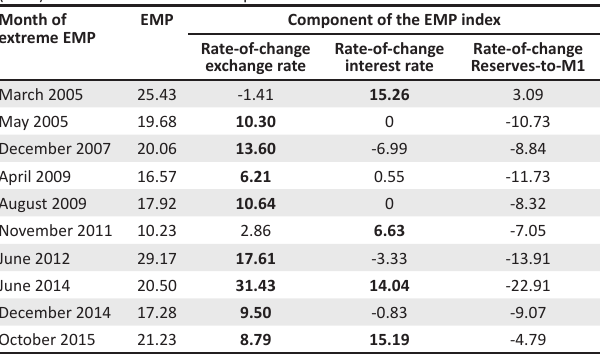
TABLE 13: Kenya – Extreme pressure or crisis of the exchange market pressure (EMP) index with individual components for each month. Month of EMP Component of the EMP index extreme EMP Rate-of-change Rate-of-change exchange rate interest rate